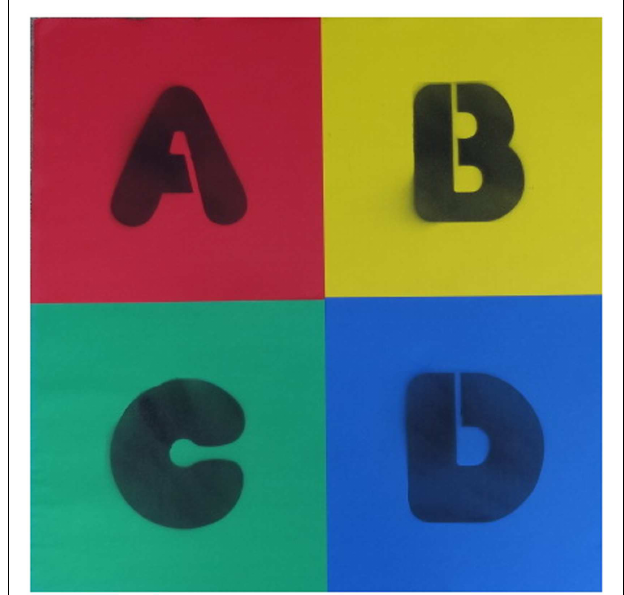
FIGURE 1 | Jump In ! educational response mat